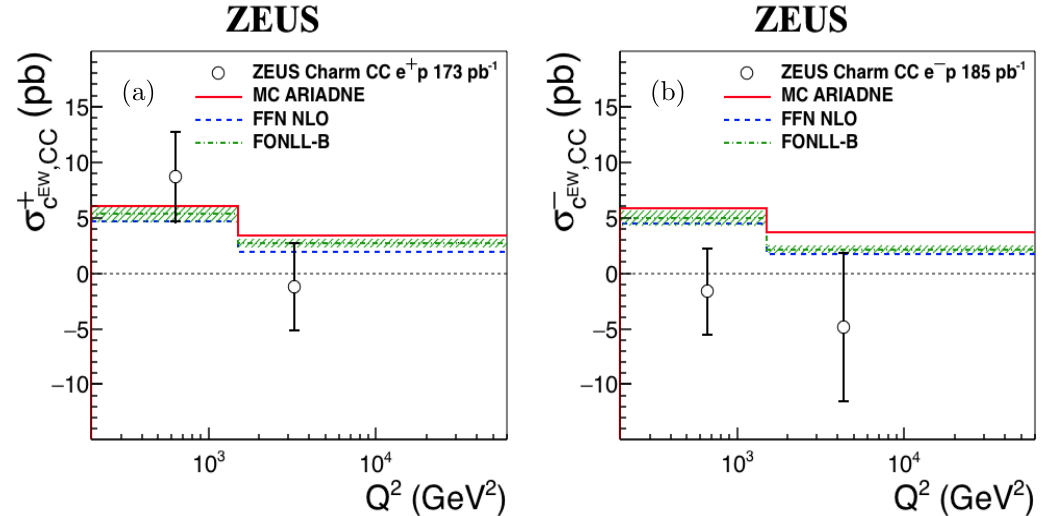
Figure 10. The EW charm cross sections, (cid:27) , in two bins of Q 2 for (a) e + p and (b) e (cid:0) p c EW collisions. The vertical error bars show the total uncertainties; the included systematic uncertainties are negligible. The solid lines represent predictions obtained with the ARIADNE MC. The dashed and dashed-dotted lines represent, respectively, predictions from the FFN and FONLL-B schemes. Hatched bands are the total uncertainty in the predictions from FONLL-B schemes.